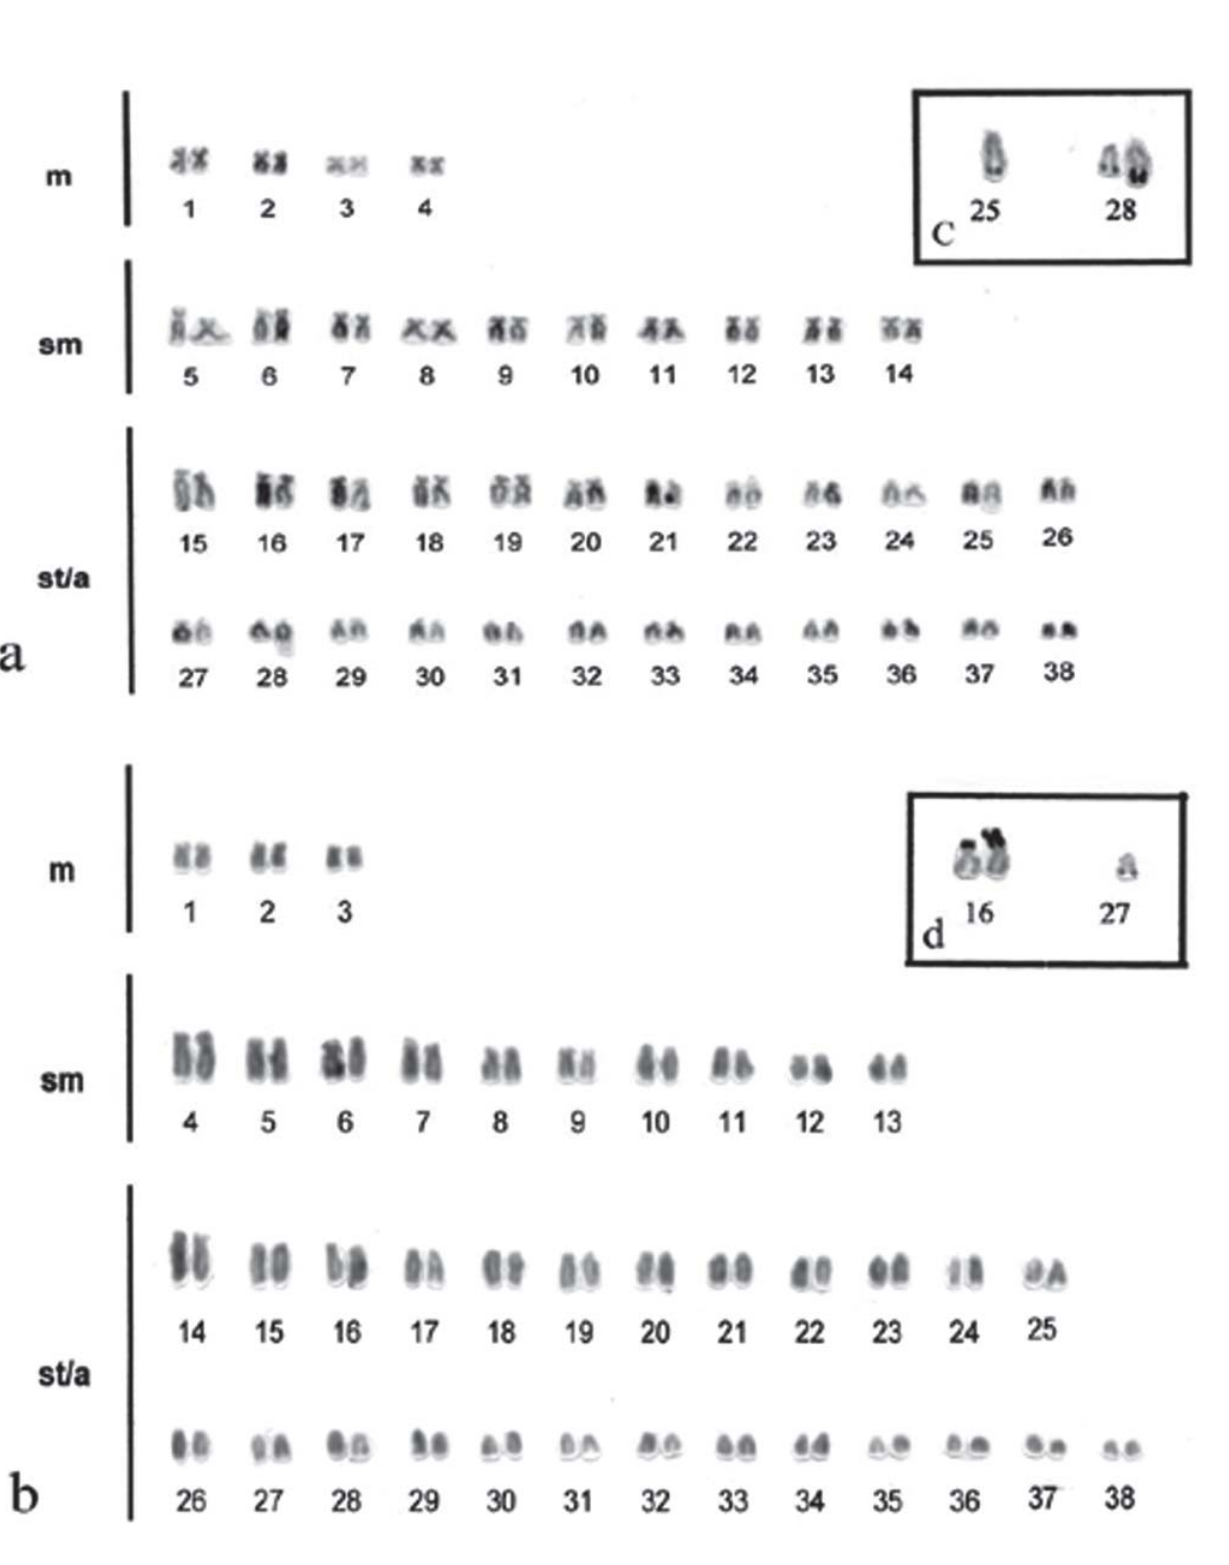
Fig. 2. Karyotypes of Hypostomus nigromaculatus with conventional Giemsa staining: a ) rio Mogi-Guaçu and b ) tributaries of the rio Tibagi. Ag-NOR-bearing chromosomes from rio Mogi-Guaçu ( c) and tributaries of the rio Tibagi (d) are